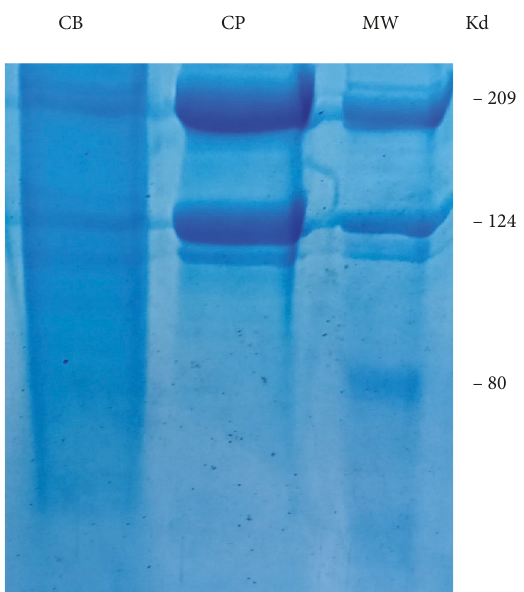
Figure 3: 7% SDS-PAGE showing acid-soluble collagen from different origins. MW: molecular weight standards. CM: marine collagen; CB: bovine collagen.